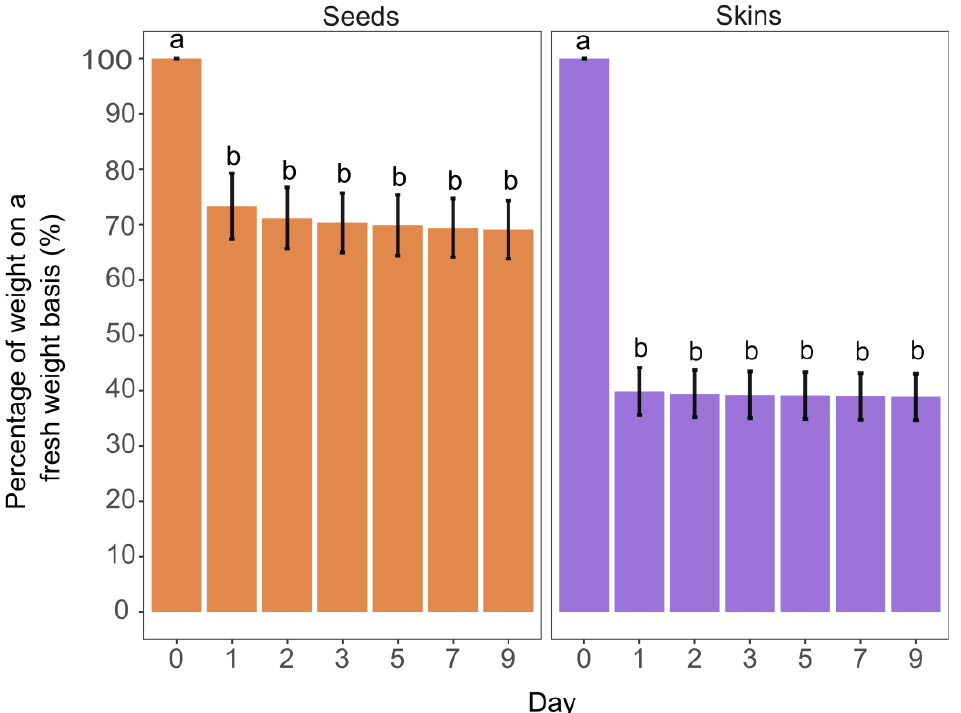
Figure 1. Percentage of weight as regard to fresh weight of non-ground grape skins and seeds during the lyophilisation process. Error bars represent the standard deviation of three replicates and different letters indicate statistically significant differences between lyophilisation days in terms of sample weight (Kruskal – Wallis test, p < 0.05).